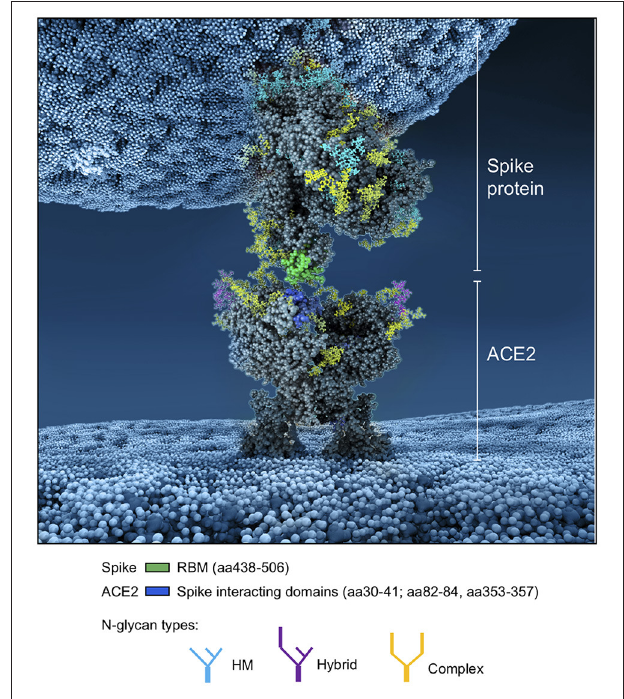
FIGURE 12 | Atomistic reconstruction of the SARS-CoV-2 spike—ACE2 interaction. A representation of the interaction between a glycosylated spike in open conformation with its glycosylated receptor ACE2 was generated with BioExplorer. The binding domains in the spike and ACE2 involved in the interaction are colored in green and blue, respectively. Note that not all glycans are present on the open spike (see section Methods for